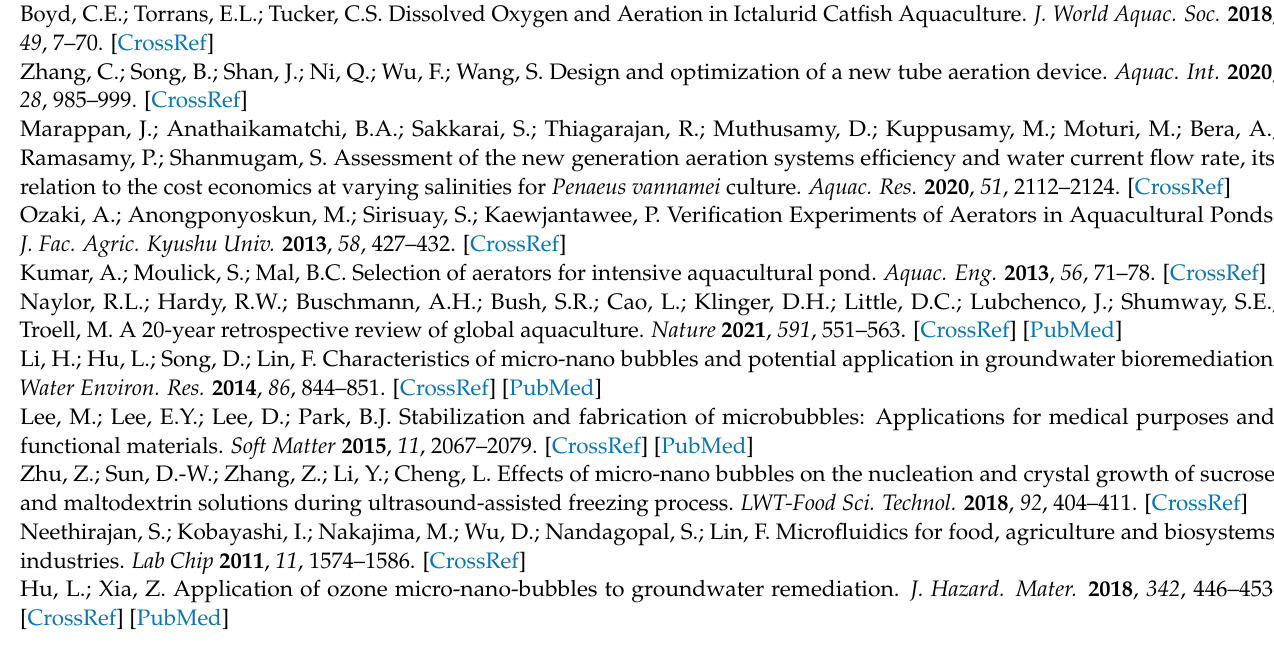
Figure S2: (A) abundance grading curve of sediment microbial community, (B) sparse curves of sediment microbial communities (the exponent type is Shannon), (C) sparse curves of sediment microbial communities (the exponent type is Pielou_e); Table S1: the average number of detectable ASVs species in water, sediment, and intestinal samples under the action of nano-aerator and